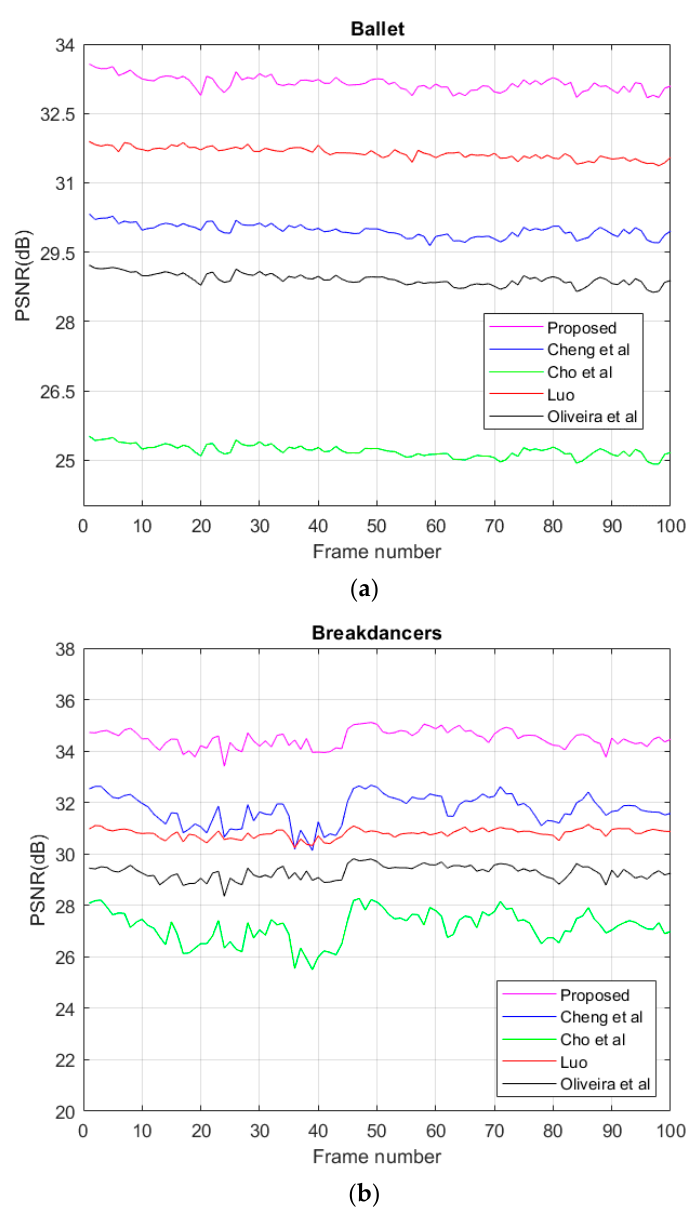
Figure 16. Comparative results of peak signal-to-noise ratio (PSNR) value by frame. ( a ) Ballet dataset and ( b ) Breakdancers dataset.